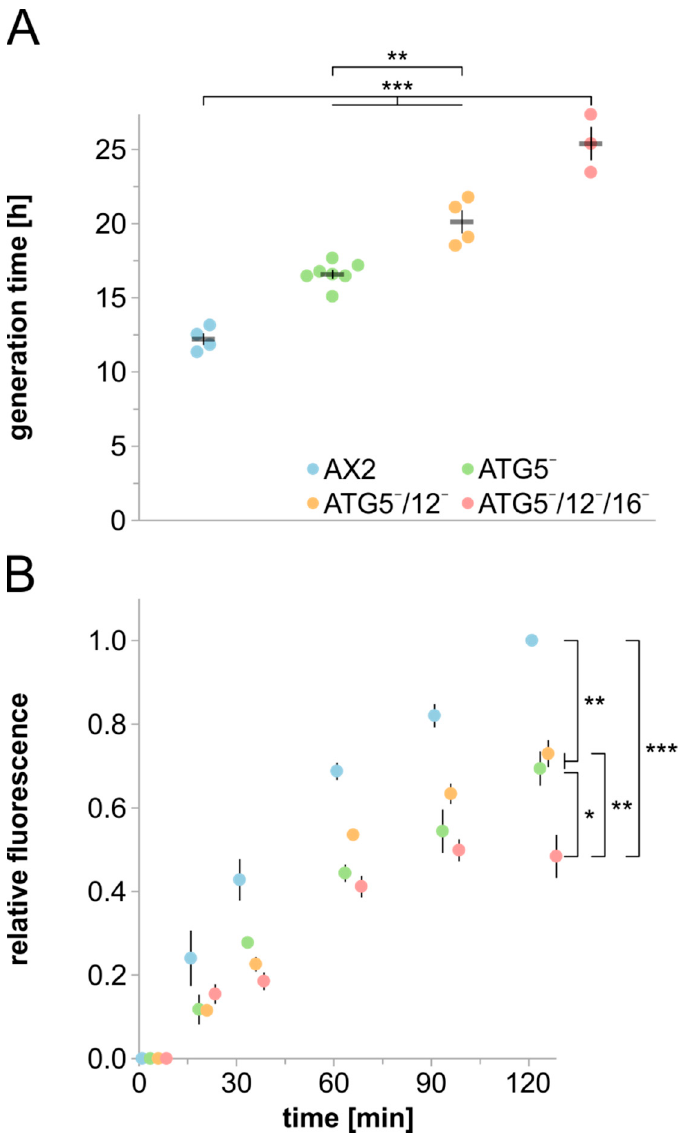
Figure 5. Analysis of cell growth and macropinocytosis in AX2 and mutant strains. ( A ) Generation time of AX2, ATG5¯, ATG5¯/12¯ and ATG5¯/12¯/16¯ cells in shaking culture. Cell titres of three parallel shaking cultures were determined every 24 h. Mean values and SEM of three (ATG5¯/12¯/16¯), four (AX2 and ATG5¯/12¯) and seven (ATG5¯) independent experiments are shown. For statistical analysis, one-way ANOVA and Tukey’s test as post hoc analysis were used. ( B ) Macropinocytosis of TRITC-labelled dextran. AX2, ATG5¯, ATG5¯/12¯ and ATG5¯/12¯/16¯ cells were adjusted to 6 × 10 6 cells/mL and co-incubated with TRITC-labelled dextran. Intracellular fluorescence was determined at t0 and after 15, 30, 60, 90, and 120 min. The final fluorescence of AX2 was set to 1. Color assignment of strains is as in panel A. Mean values and SEM of three independent experiments are shown. For statistical analysis, two-way ANOVA and Tukey’s test as post hoc analysis were used. *, significant ( p -value < 0.05); **, very significant ( p -value < 0.01); ***, highly significant ( p -value < 0.001).